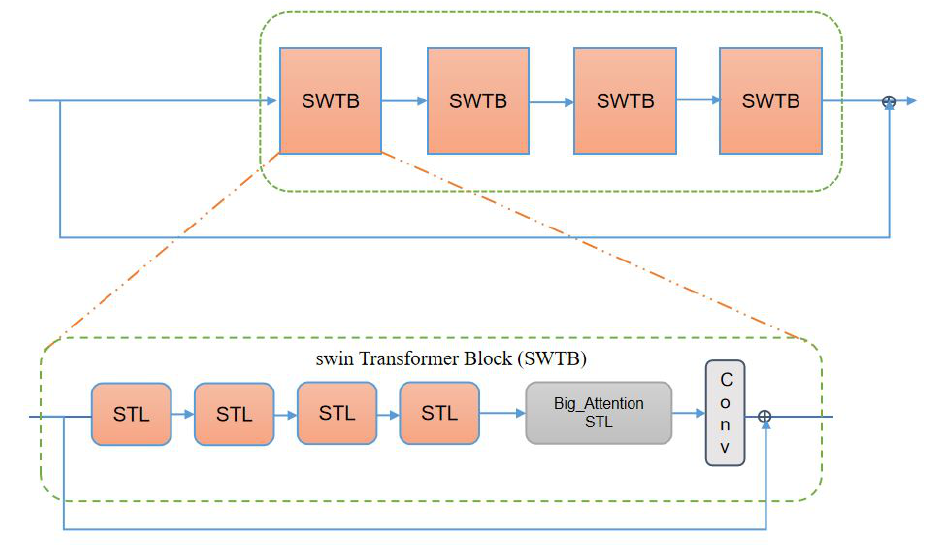
Figure 12. Swin Transformer block